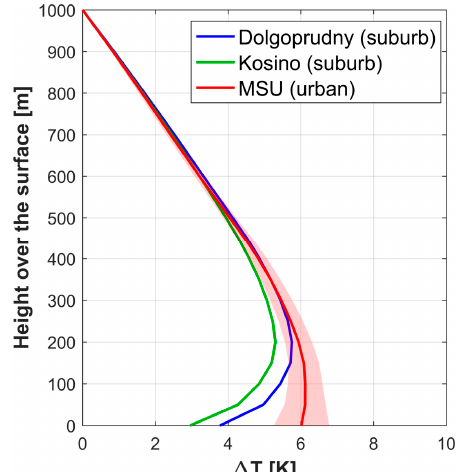
Figure 5. Vertical profiles of mean temperature deviation from the top level of measurements ( Δ T), calculated according to MTP-5 measurements for the selections of nocturnal cases with pronounced urban heat island during 17 April–3 July 2015. Red shading shows the confidence interval for the urban site (MSU). Adopted from [79].